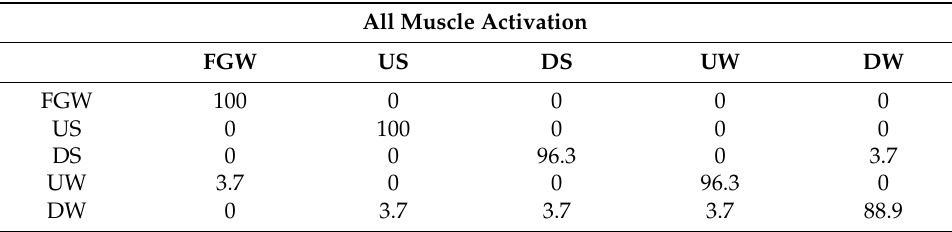
Table 3. Confusion matrix for walking environment classification using sEMG signals as input.